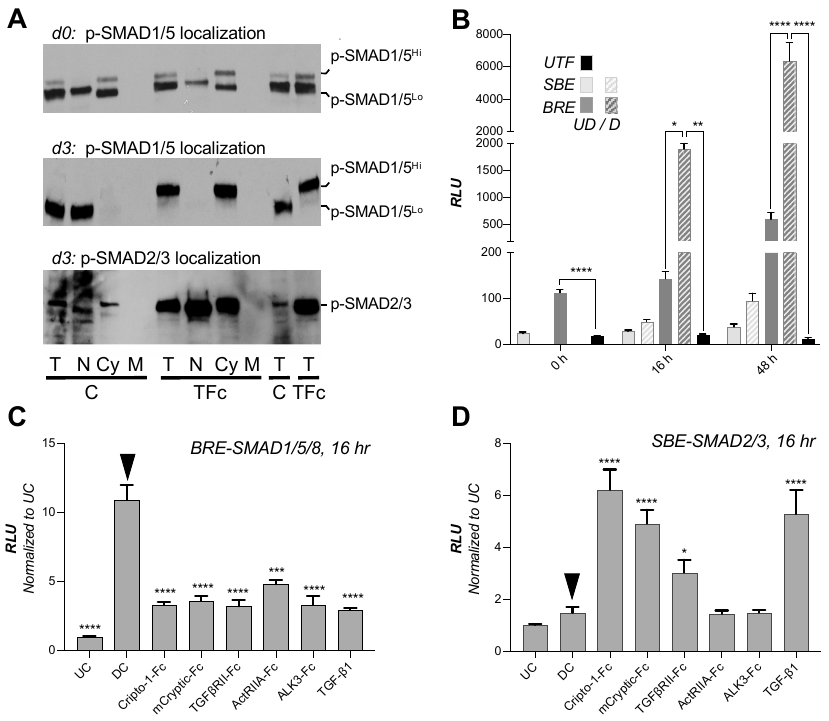
Figure 6. Electrophoretic mobility shift is associated with p-SMAD1/5 hyper-phosphorylation and leads to reduced p-SMAD1/5 nuclear translocation. ( A ) SMAD localization by cellular fractionation. Total cell lysate (T), nuclear (N), cytoplasmic (Cy), and membrane (M) fractions of vehicle control (C) and TGF β RII-Fc (TFc) treated samples were analyzed by Western blot after cellular fractionation using p-SMAD1/5/8 and p-SMAD2/3 antibodies. The top panel and the middle and bottom panels show samples with treatment beginning at d-2 and d0 and collected at d0 and d3 of differentiation, respectively. p-SMAD1/5 Hi is found in the cytoplasmic fraction in all TGF β RII-Fc treated samples. Only p-SMAD1/5 Lo is found in the nuclear fraction. A total of 10 µg of protein, as determined by per lane, were loaded. WB quantifications are shown in Table S4. Total SMAD loading controls, and tubulin localization controls are shown in Figure S7. ( B ) Dual luciferase reporter assay in 3T3-L1 cells shows basal SMAD1/5/8 and SMAD2/3 signaling as noted at 0 (light grey) and 16 (dark grey) hours of differentiation. Samples represented by solid bars were undifferentiated (UD), samples represented by stripped bars were treated with differentiation reagents (D). Firefly luciferase reporter lacking control (untransfected, UTF) is shown as black bar. Data were analyzed using Prism 9 and statistical significance from four biological replicates was determined by one-way ANOVA and Fisher’s LSD tests (* p < 0.05; ** p < 0.01; *** p < 0.001; **** p < 0.0001). Measurements were taken at 0, 12 and 48 h post differentiation as noted. ( C ) Dual luciferase reporter assay in 3T3-L1 cells shows SMAD1/5/8 signaling at 16 h of differentiation. Samples were treated with different ligands or traps as noted. Both reporter plasmid transfection and treatment started at 0 h of differentiation. The SMAD1/5/8 dependent firefly luciferase signal was normalized against Renilla luciferase control. Data are shown as fold induction relative to undifferentiated control (UC). Data were analyzed